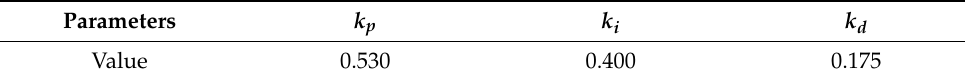
Table 5. Control parameters of the heading PID controller.